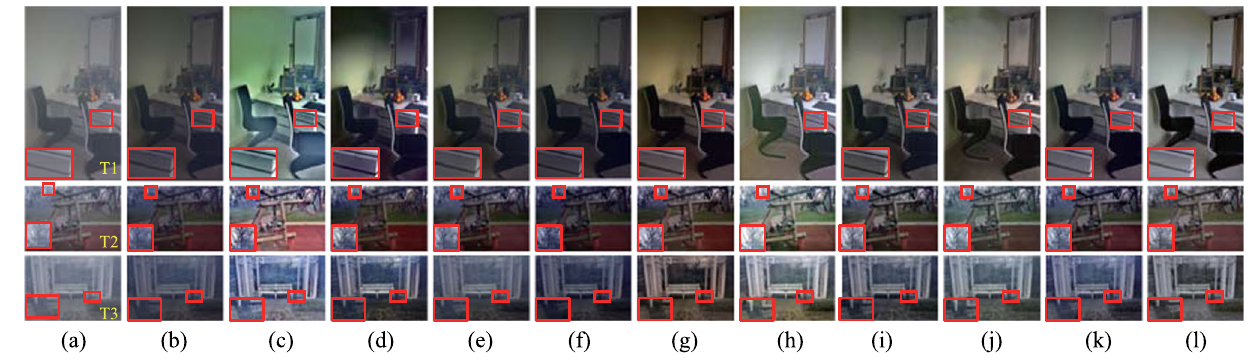
Fig. 7 SZDNet and well-known methods were compared qualitatively on real-world datasets. a Hazy images. b DCP [18]. c IDE [33]. d DDAP